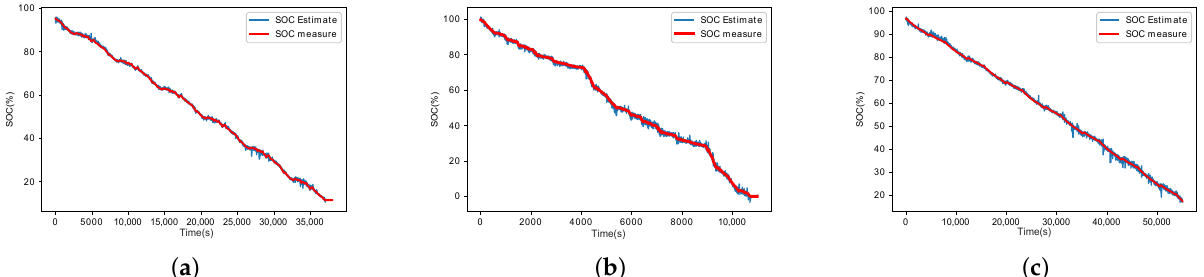
Figure 8. SOC estimation for Panasonic 18650PF battery with RoLSTM for: ( a ) 0 ◦ C; ( b ) 25 ◦ C; and ( c ) different ambient temperature.